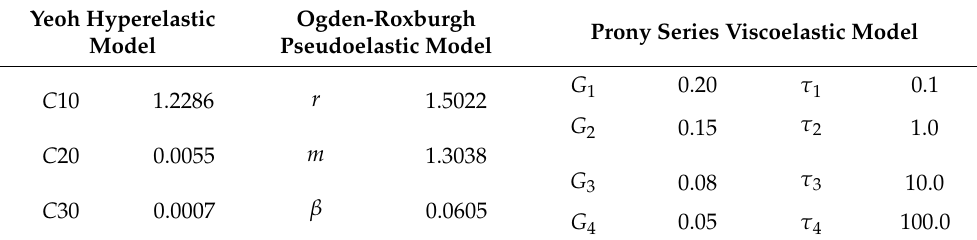
Table 1. The initial material parameters in hyper-pseudo-viscoelastic model for the carcass rubber and belt